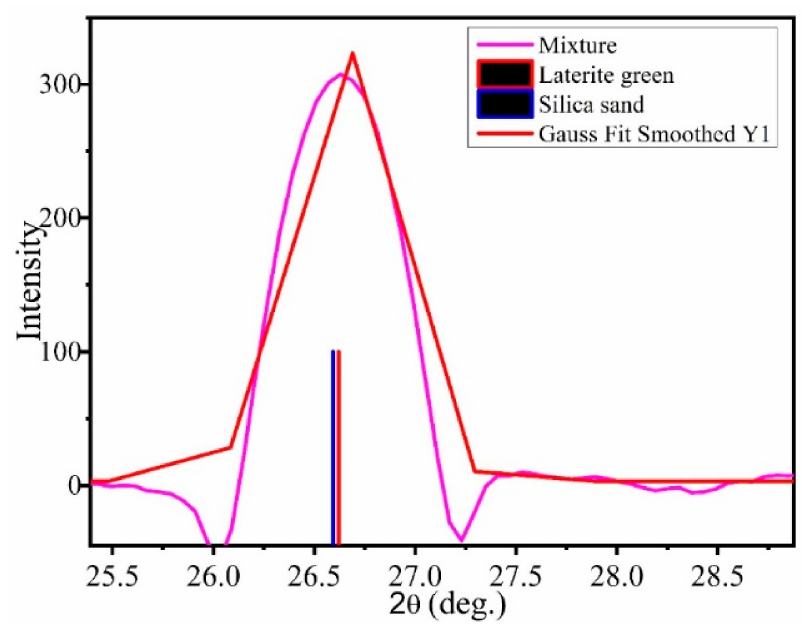
Figure 21. Gaussian fitting of laterite green and silica